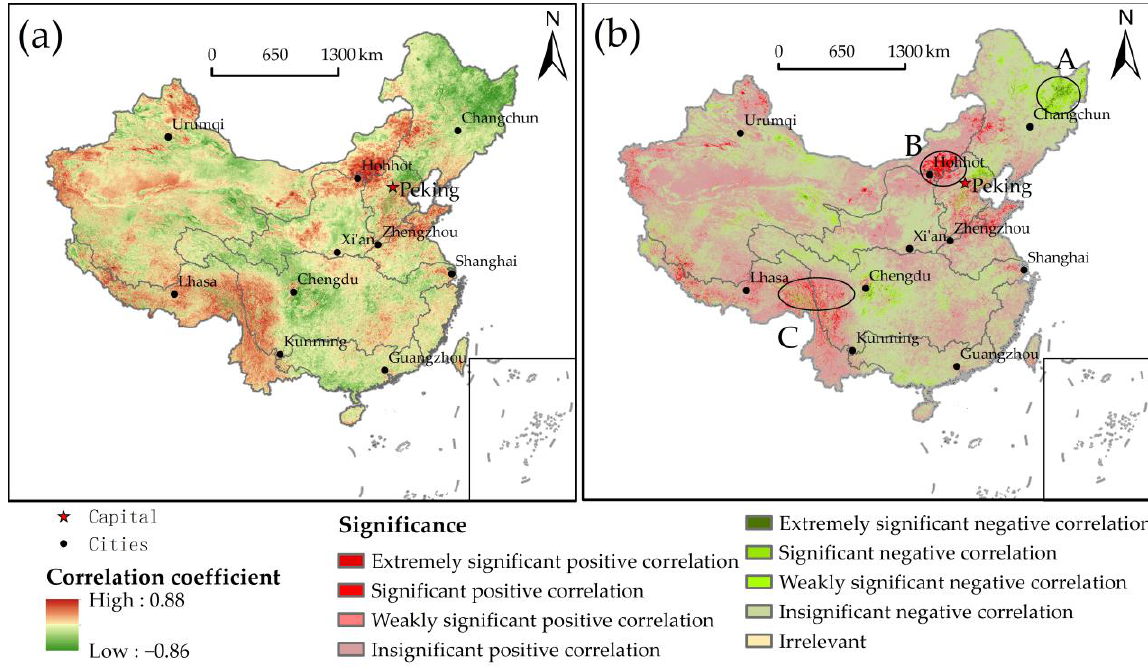
Figure 5. ( a ) Spatial distribution of the correlation between the NDVI and SPEI in China from 1998–2017; and ( b ) spatial distribution of significant correlations between NDVI and SPEI in China from 1998‒2017.